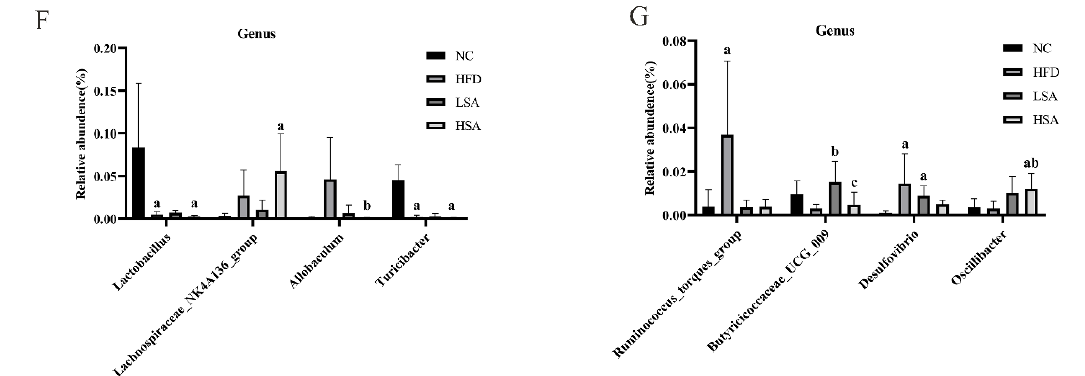
Figure 4. SA supplementation altered overall gut microbial structure. ( A ) Venn diagram, the num- bers indicated sequencing reads; ( B ) principal coordinates analysis; ( C ) the microbial distributions at the phylum level; ( D ) the microbial distributions at the genus level; ( E − G ) relative abundance of bacteria at the genus level. n = 5 − 6 each group. a p < 0.05, compared to the NC group; b p < 0.05, compared to the HFD group; c p < 0.05, compared to the LSA group.